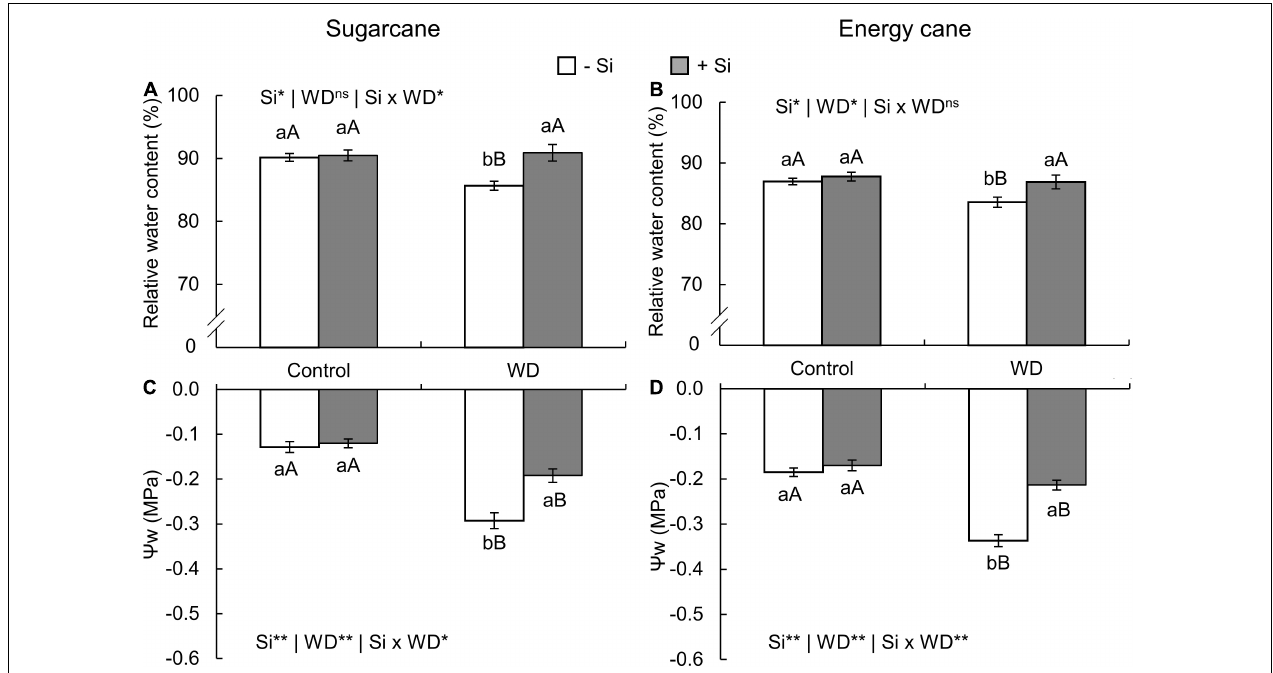
FIGURE 7 | Relative water content and leaf water potential ( (cid:57) w) in the sugarcane (A,C) and energy cane plants (B,D) in -Si and + Si under adequate water regime (control) and in WD for a period of 7 to 60 days after transplantation. ** and * significant with 1 and 5% probability, respectively, and ns, not significant by the F -test. Lowercase letters indicate differences in relation to Si and capital letters in relation to water deficit. n = 6. Si × WD: interaction.